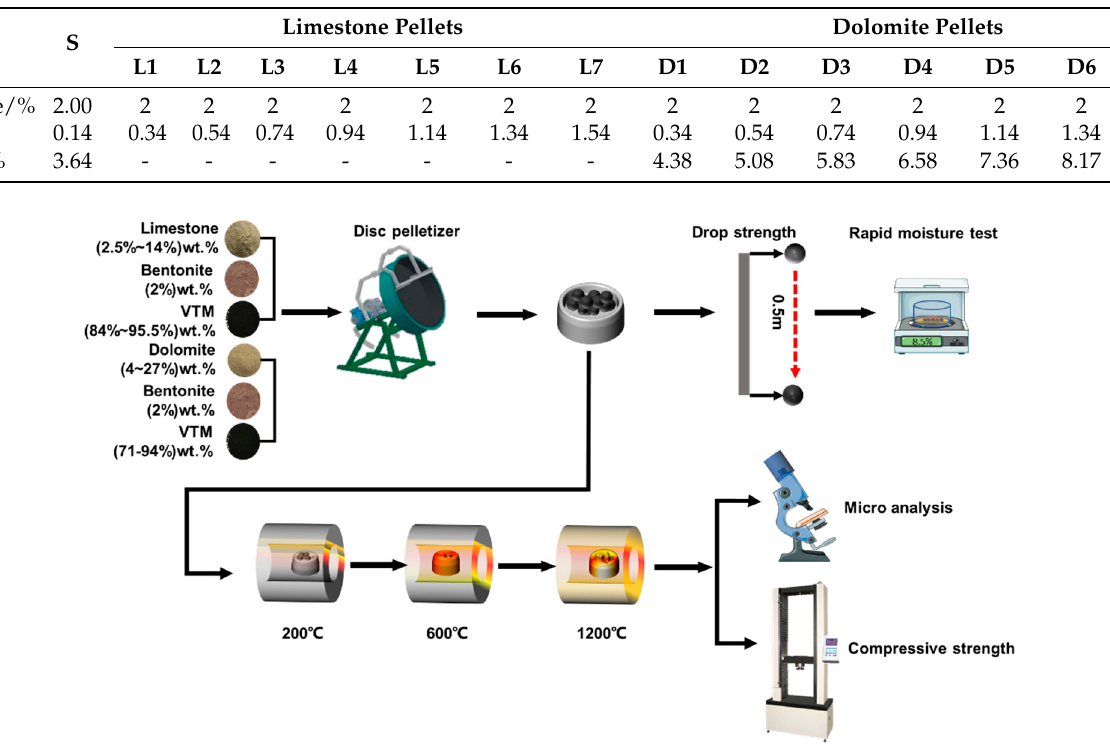
Figure 2. The experimental process of the flux pellets.